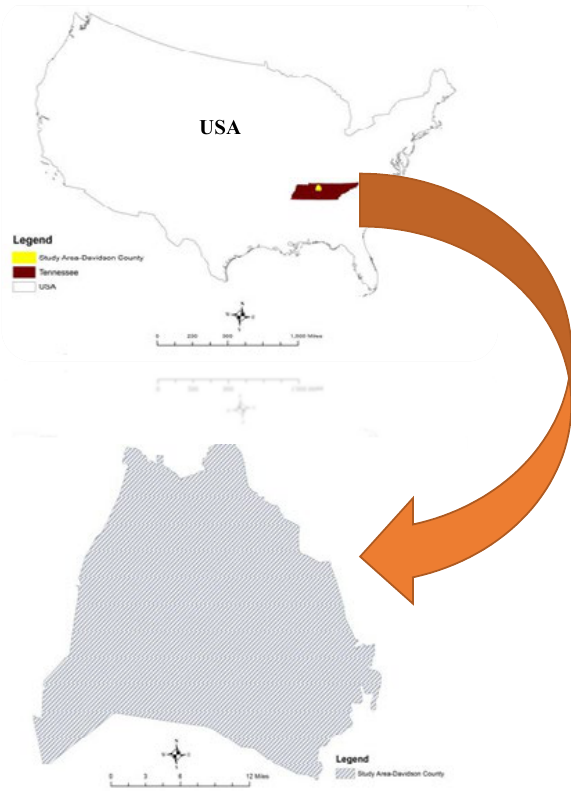
Fig. 1: Geographic location of the Area of Study-Davidson County, Tennessee